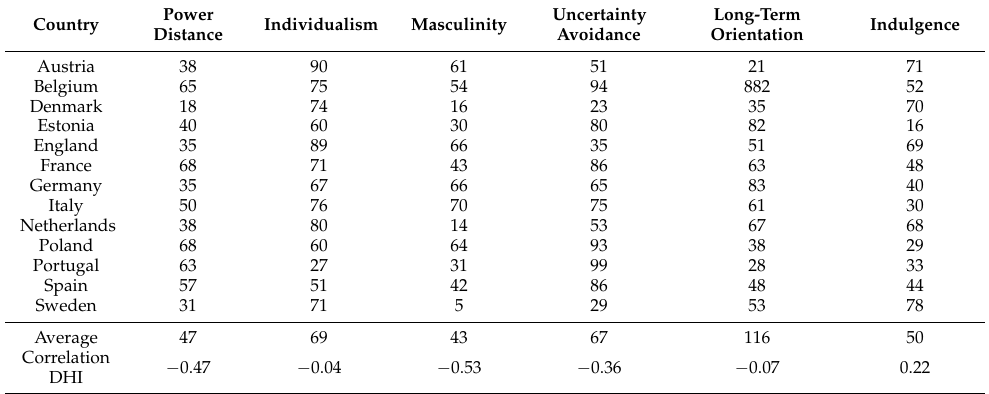
Table 3. Dimensions on Selection National Cultures. Source: own compilation based on GfK-data [28]. Country Power Distance Individualism Masculinity Uncertainty Avoidance Long-Term Orientation